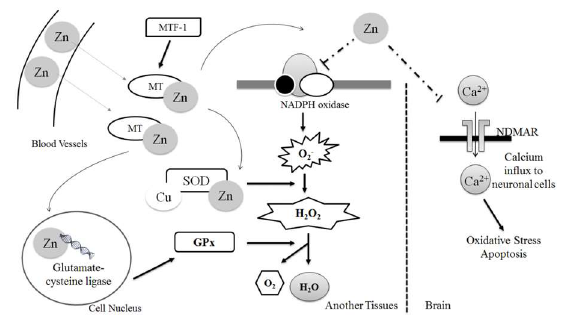
Figure 5. The mechanistic role of zinc in the antioxidant defense system